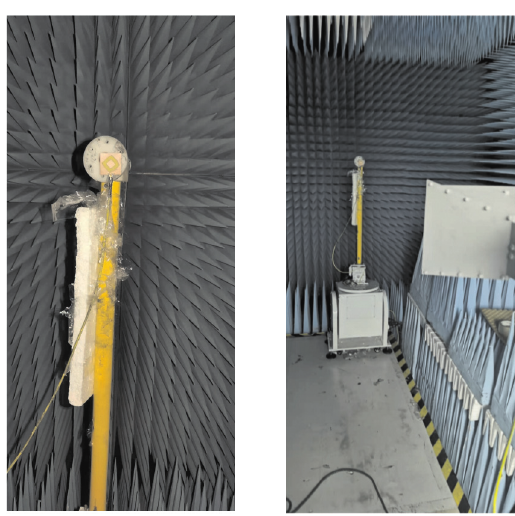
Figure 11: Photograph of the test